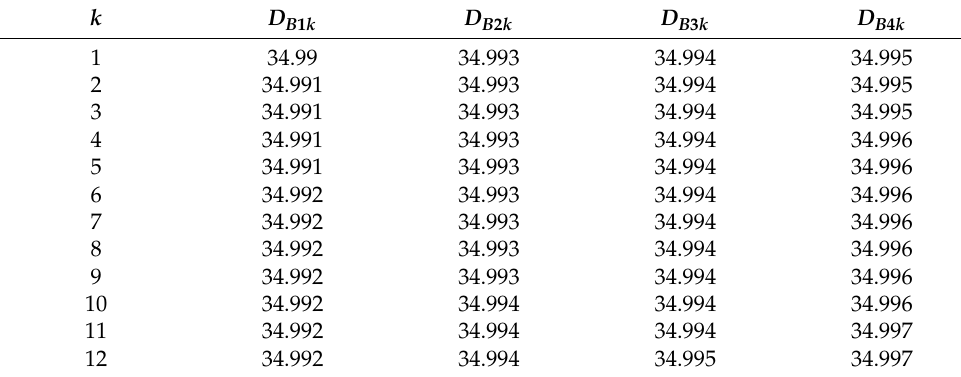
Table 4. Dimensions details of Part B in each bin.